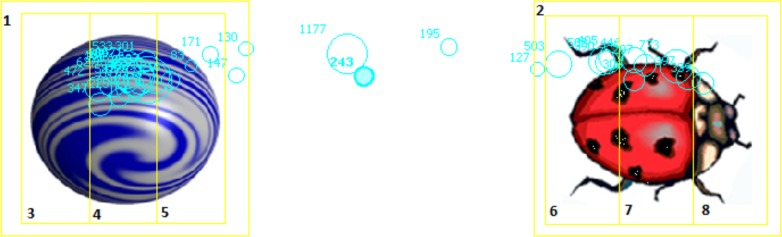
Interest areas in Experiment 2. Left areas: 3, 6; Middle areas: 4, 7; Right areas: 5, 8.